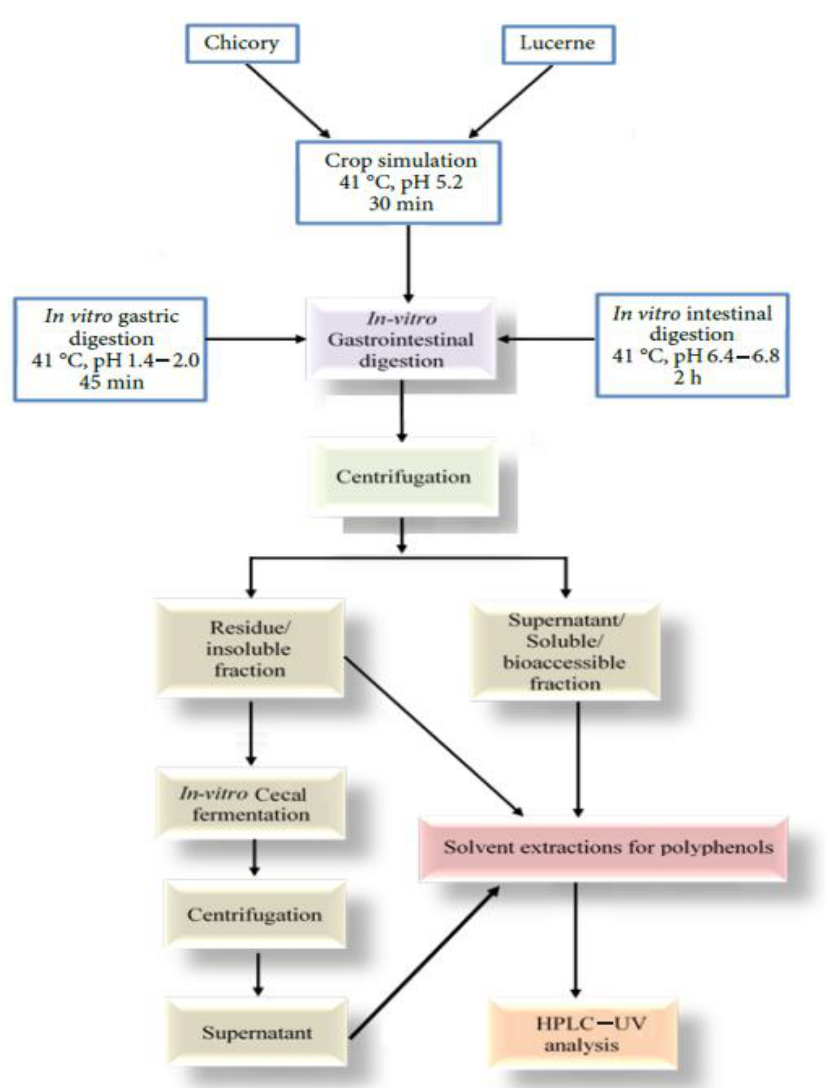
Figure 1. Schematic overview of in vitro digestion process and polyphenols analysis.